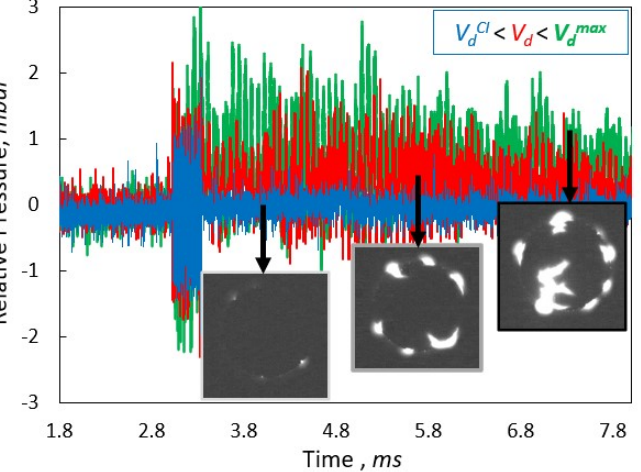
Figure 8 . Chamber relative pressure signal over time at three different driving voltages, in a range from V dCI to V dMAX .